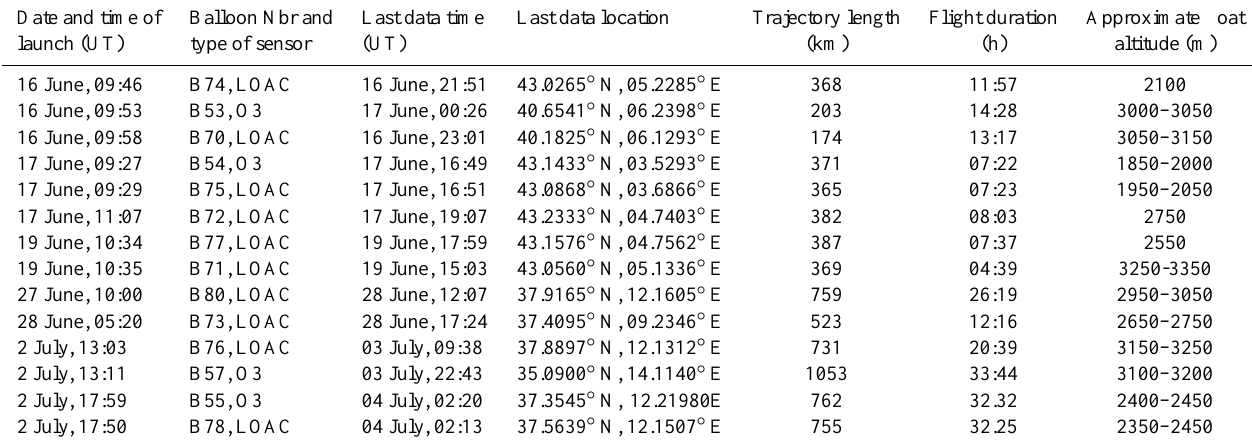
Flight duration Approximate